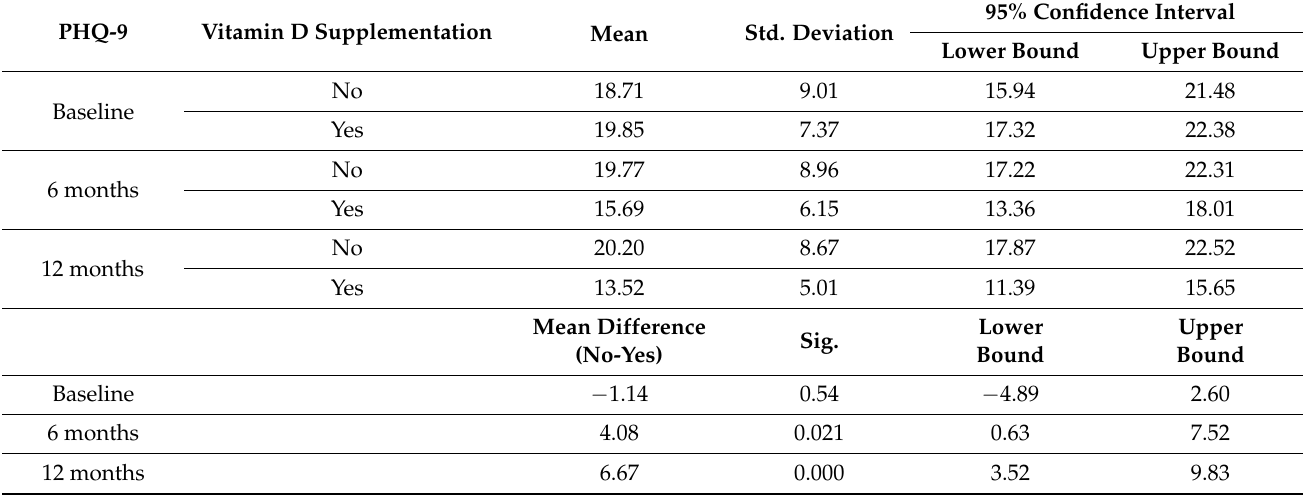
Table 4. Evolution of PHQ-9 scores and differences between the two groups throughout the study